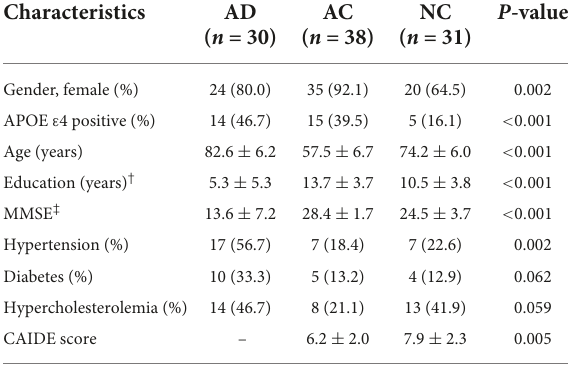
TABLE 1 Demographic and clinical characteristics of the study participants.